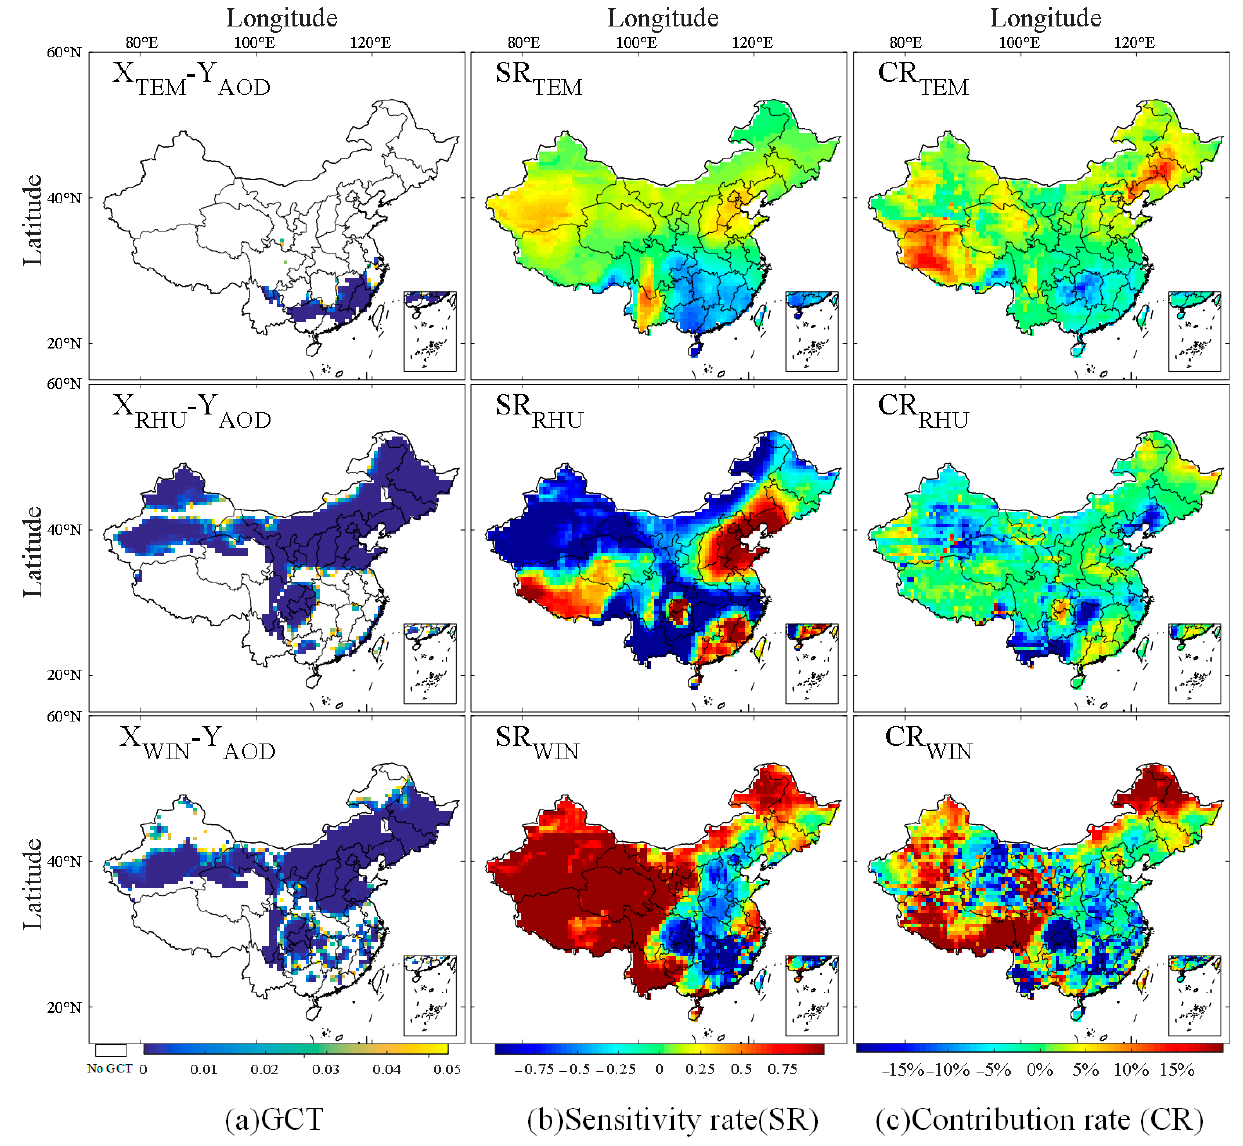
Figure 11. Results of the Granger causality test, SR, and CR analysis between AOD and meteorological driving factors. Table 4. Driving force analysis performed on a regional scale between AOD and meteorological factors of major regions.